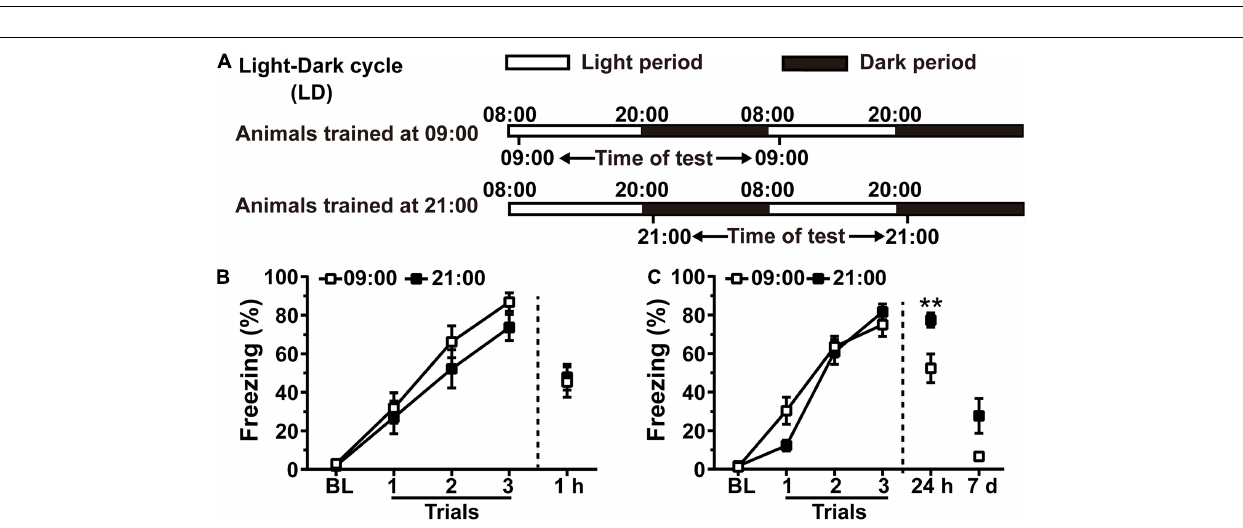
FIGURE 1 | representative WB demonstrated that Rac1 activity remarkably increased in the 21:00 group compared with the 09:00 group. Lower panel: statistical bar graph showed an obvious increase of Rac1-GTP in the 21:00 group compared with the 09:00 group. (D) Representative images of IHC for Rac1-GTP in rats. (E) The statistical bar graph showed that the integrated density of Rac1-GTP in the CA1 area was significantly decreased in the 21:00 group compared with the 09:00 group. (F) Representative images of IHC for Rac1-GTP in tree shrews. (G) The statistical bar graph showed that the integrated density of Rac1-GTP in the CA1 area was significantly increased in the 21:00 group compared with the 09:00 group. Data are presented as mean ± SEM, * p < 0.05, ** p < 0.01.